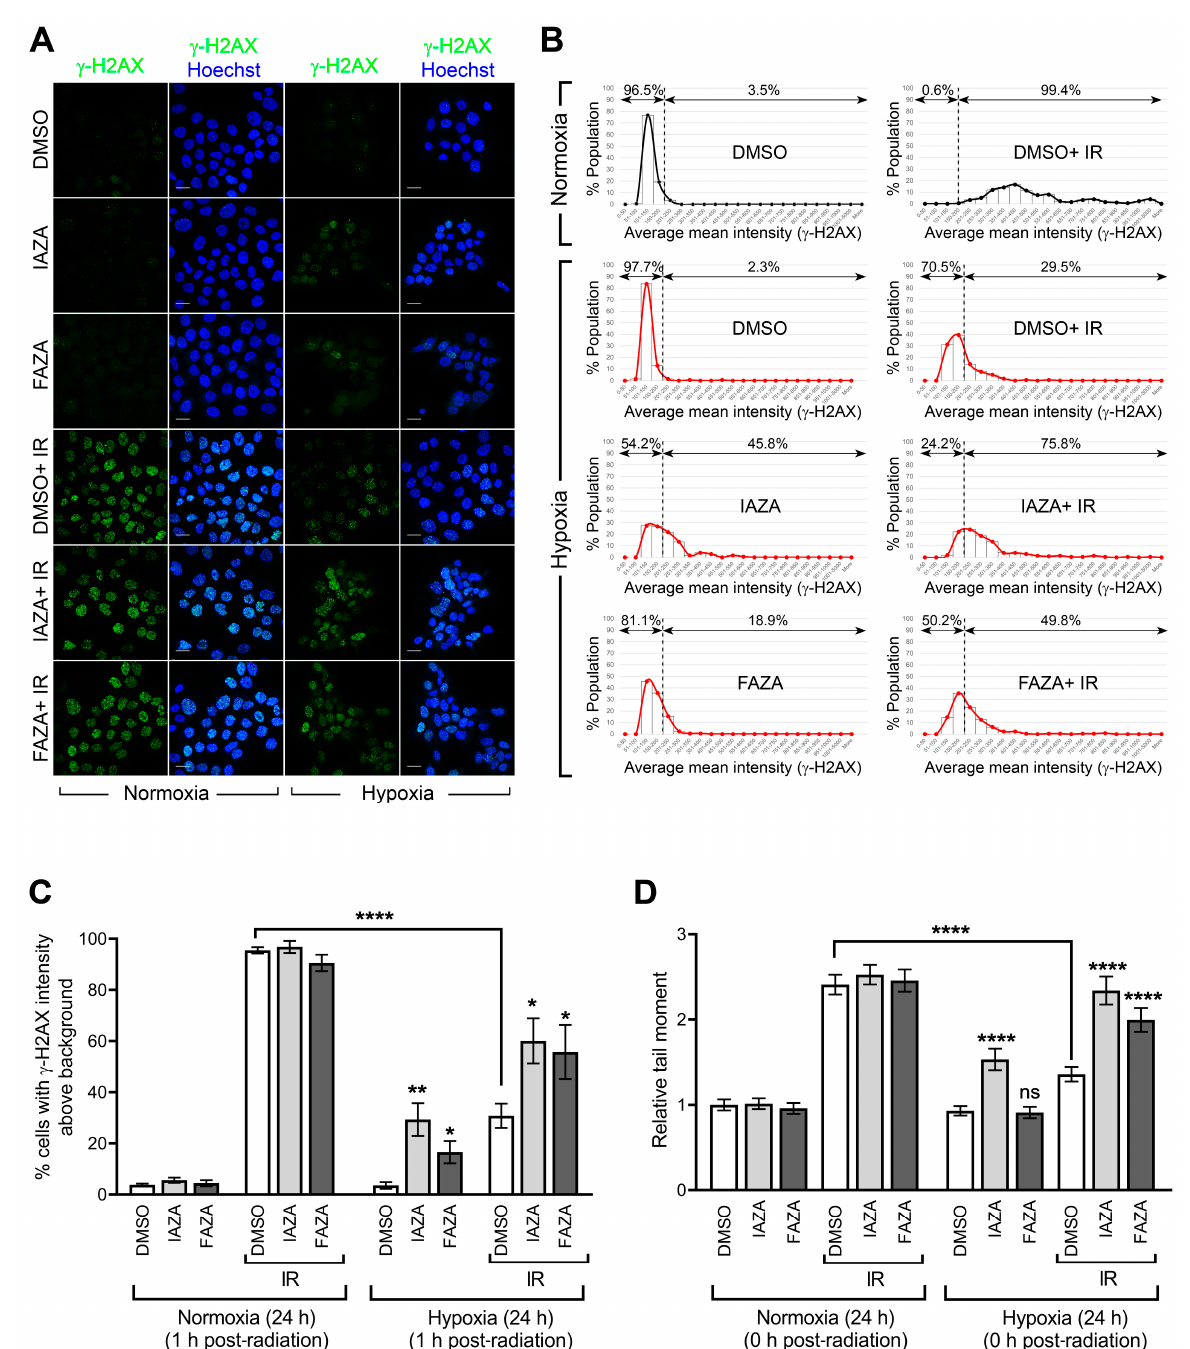
Figure 2. Co-treatment of IAZA or FAZA with 5 Gy IR increases DNA damage only under hypoxia. ( A ) Representative micrographs showing immunofluorescent staining of γ -H2AX in FaDu cells treated with vehicle control (DMSO) or drugs (IAZA or FAZA; 100 µM), with or without IR (5 Gy), under normoxia and hypoxia (<0.1% O 2 ); scale bar = 20 µm. ( B ) Representative histograms showing quantification of γ -H2AX staining intensity; dotted line shows the threshold for background levels of γ -H2AX staining. ( C ) Treatment with IAZA and FAZA increases the percentage of γ -H2AX-positive population in hypoxic irradiated samples. ( D ) Alkaline comet assay shows significant increase in DNA damage in hypoxic drug-treated irradiated cells. Data show mean ± S.E.M. ( C , D ). The no-radiation arms of these data were previously reported in ref. [15] and are used here for comparison purposes.